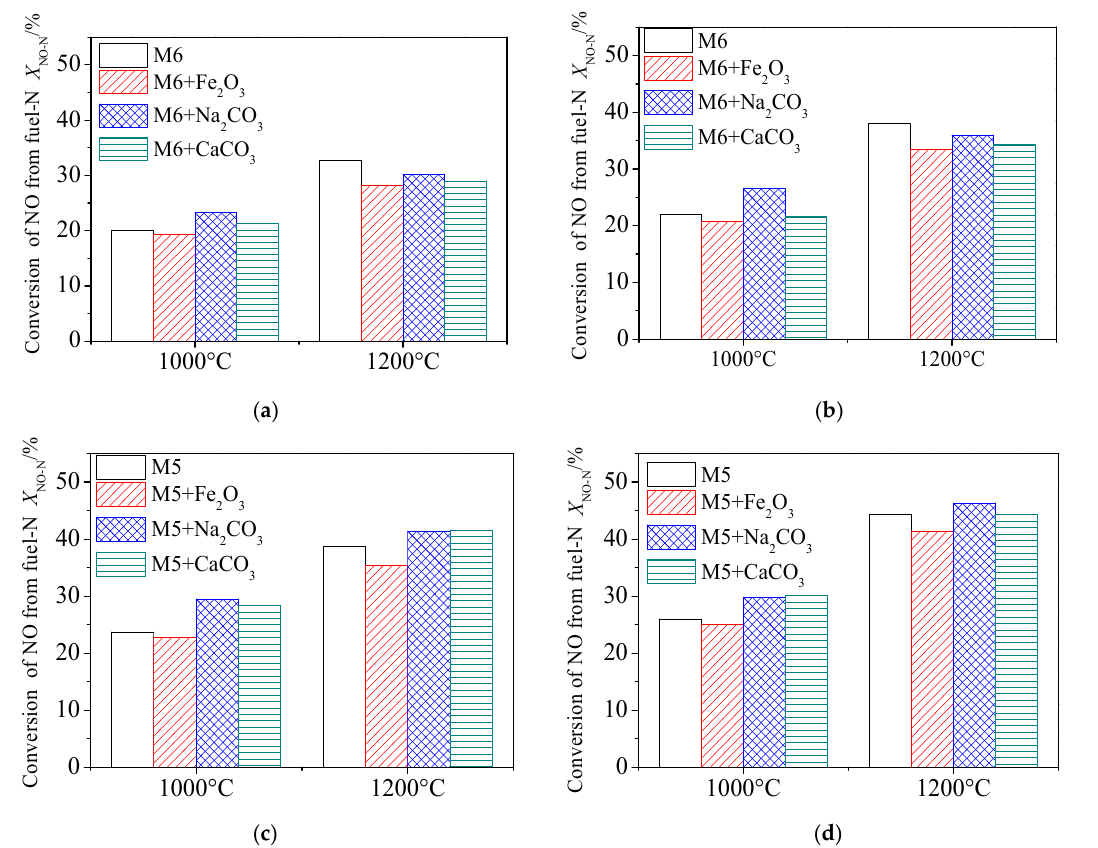
Figure 8. The effects of mineral matters on NO x emission during air and oxy-fuel combustion. ( a ) “M6” in 21% O 2 /79% CO 2 atmosphere; ( b ) “M6” in 21% O 2 /79% N 2 atmosphere; ( c ) “M5” in 21% O 2 /79% CO 2 atmosphere; ( d ) “M5” in 21% O 2 /79% N 2 atmosphere.